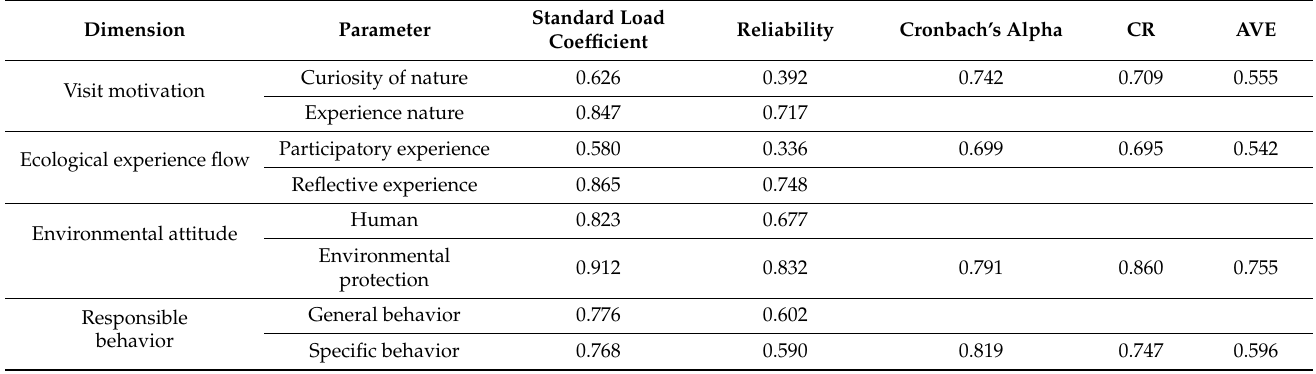
Table 4. Confirmatory factor analysis of four dimensions.